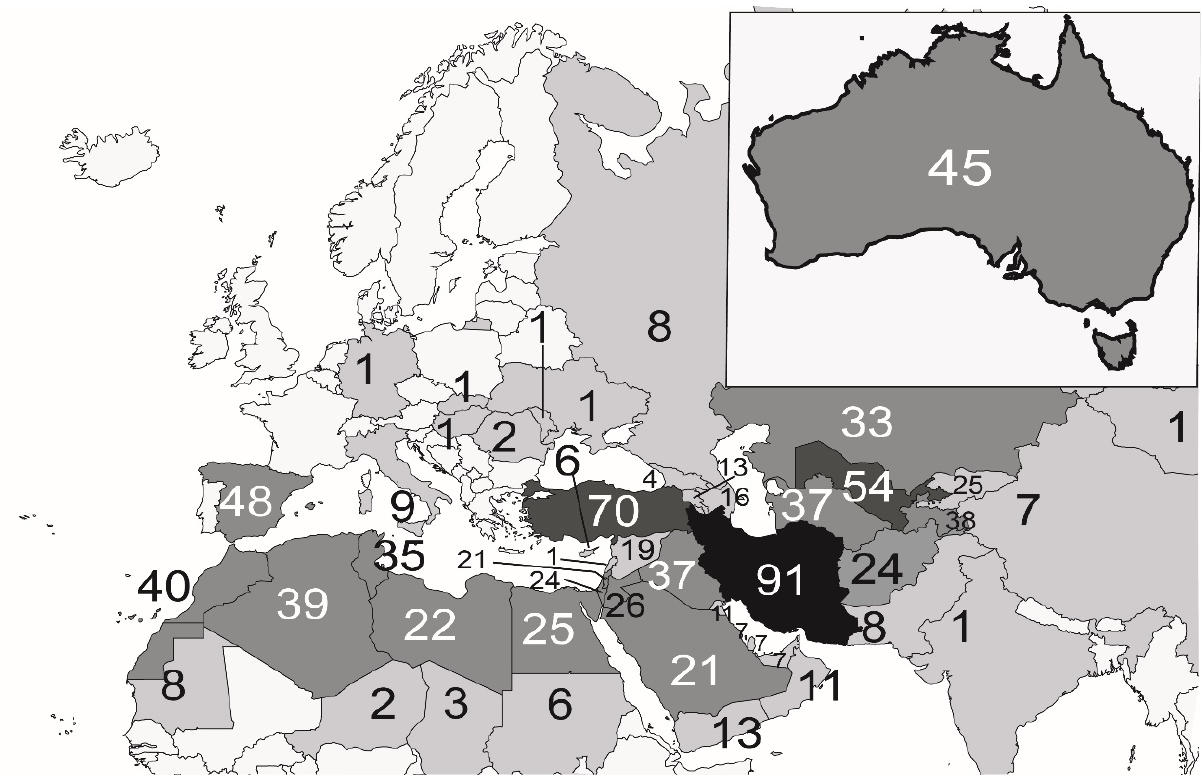
Figure 1. Number of gypsophytes in the countries of the study area. Color scale: black (> 74), dark grey (74-50), medium grey (49-20) and light grey (19-1).